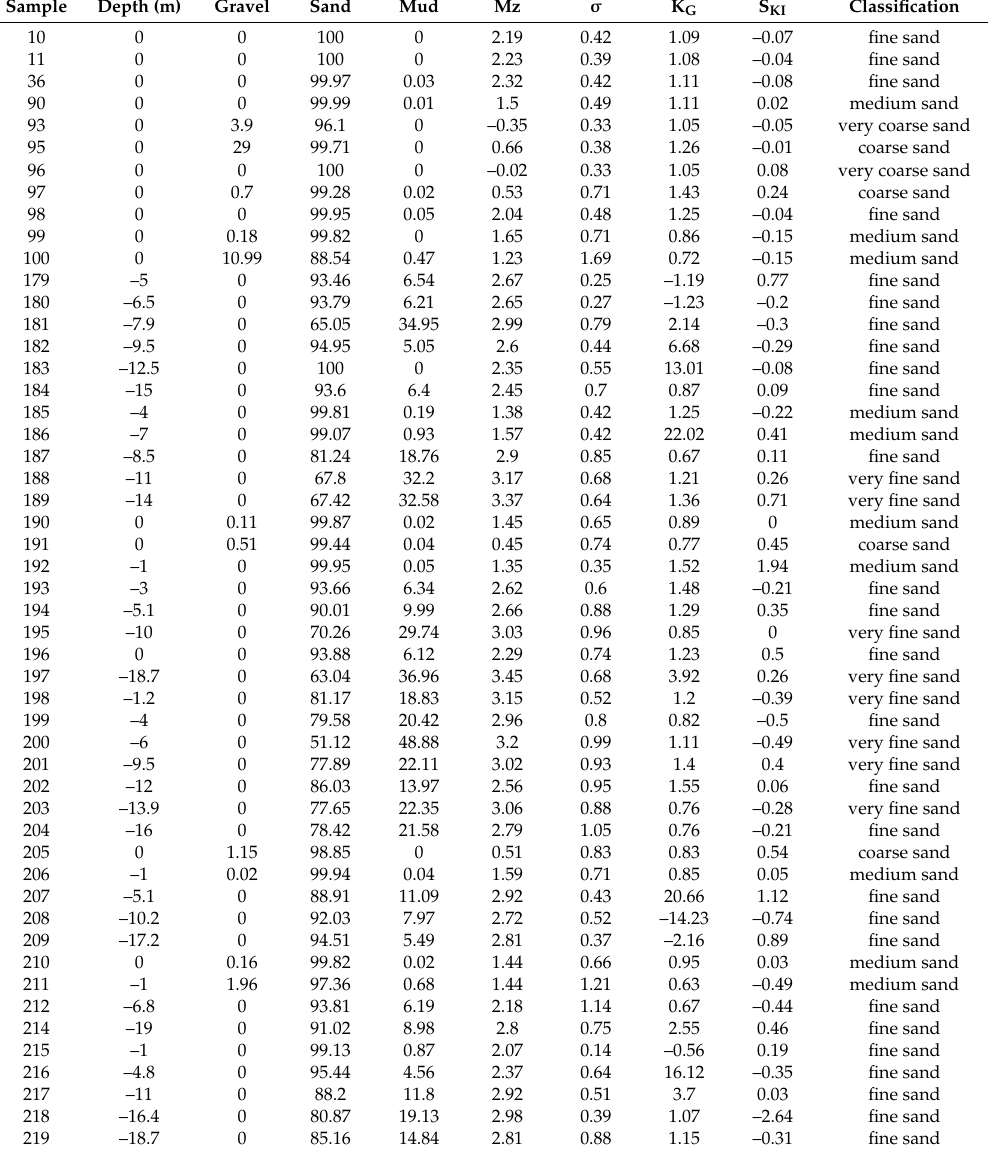
Table 1. Sediment samples collected along the shoreline and at the sea bottom Castellammare di Stabia gulf. Grain-size data and statistical parameters of the beach and marine sediments according to the graphic method of Folk and Ward (1957): Mz, mean size; σ , sorting; S KI , skewness; K G , kurtosis, and related textural group. Depths are expressed in meters and they refer to current mean sea